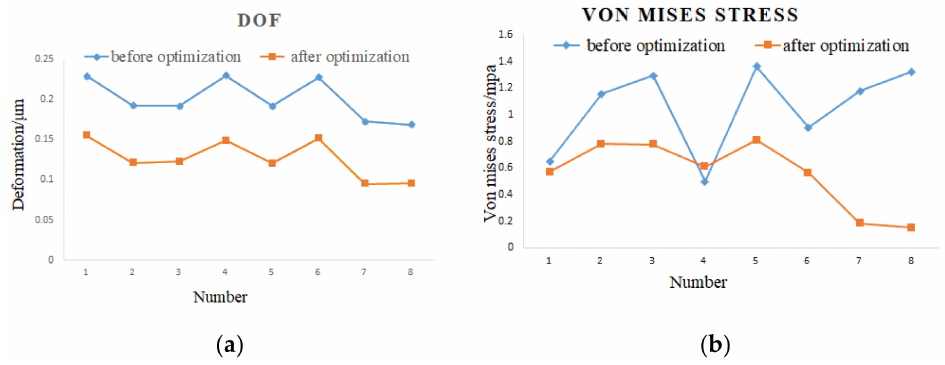
Figure 10. ( a ) Displacement of deformation. ( b ) Von Mises stress of a random node.